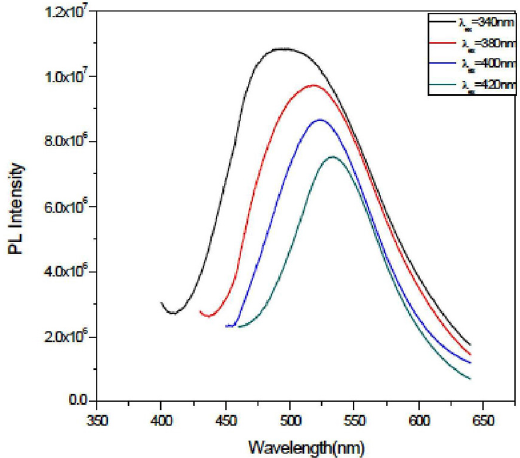
Figure 8: PL spectrum of ZnS film for different excitation